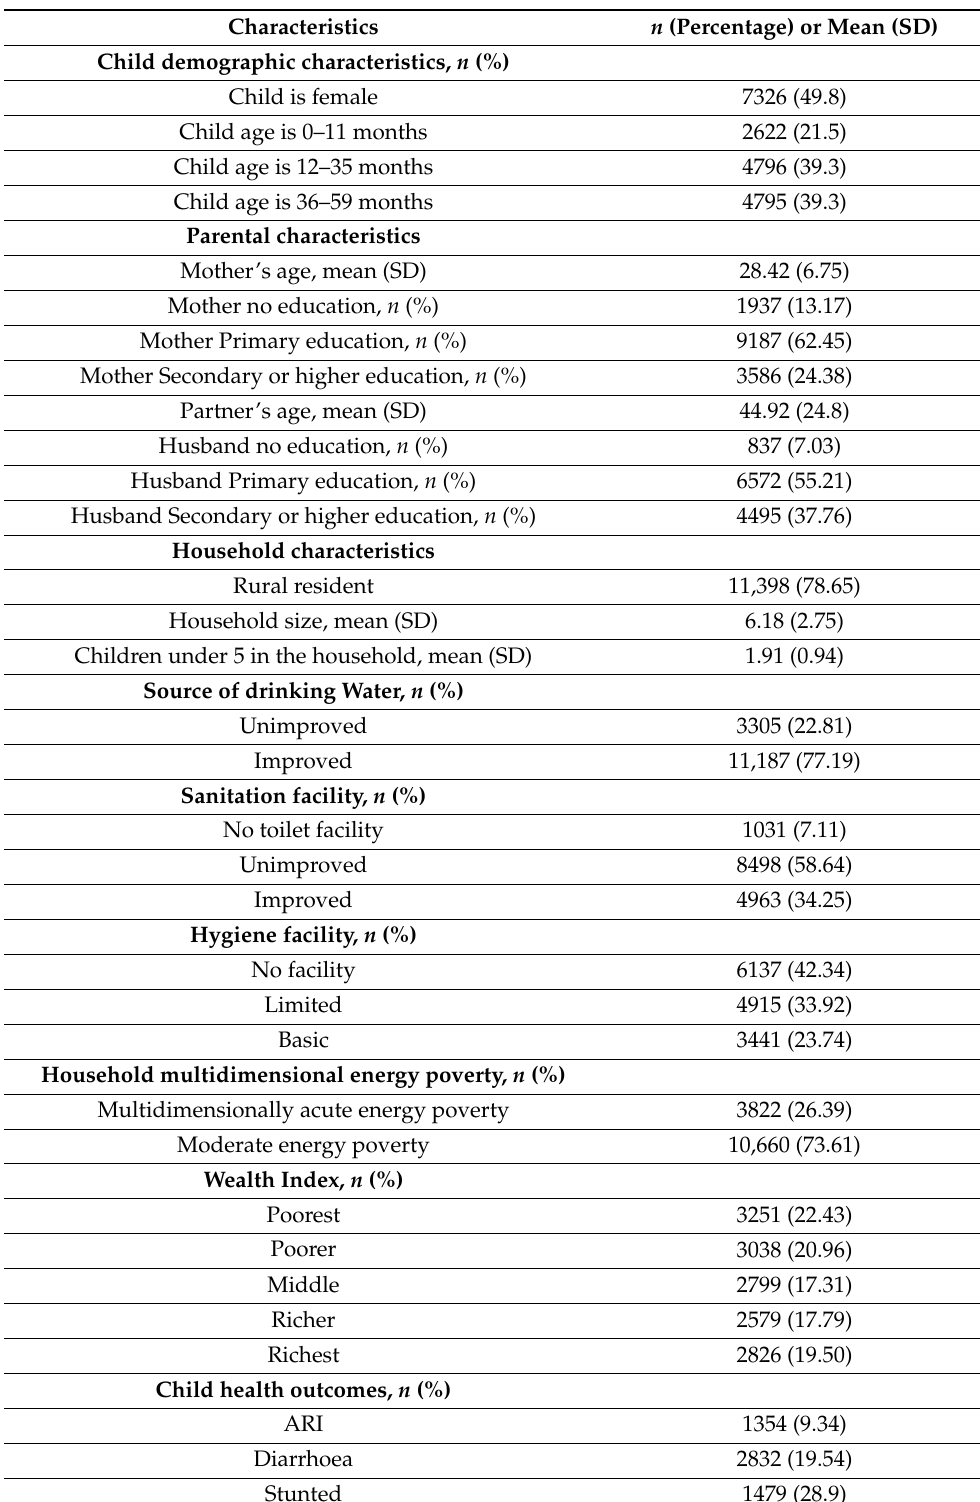
Table 3. Descriptive characteristics of study participants, n (percentage) or mean